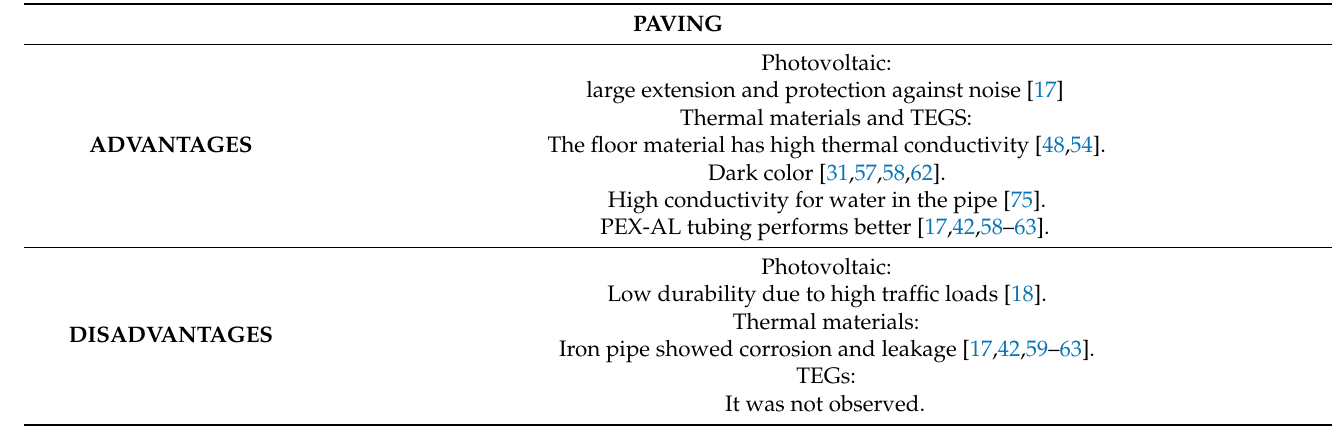
Table 4. Advantages and disadvantages in